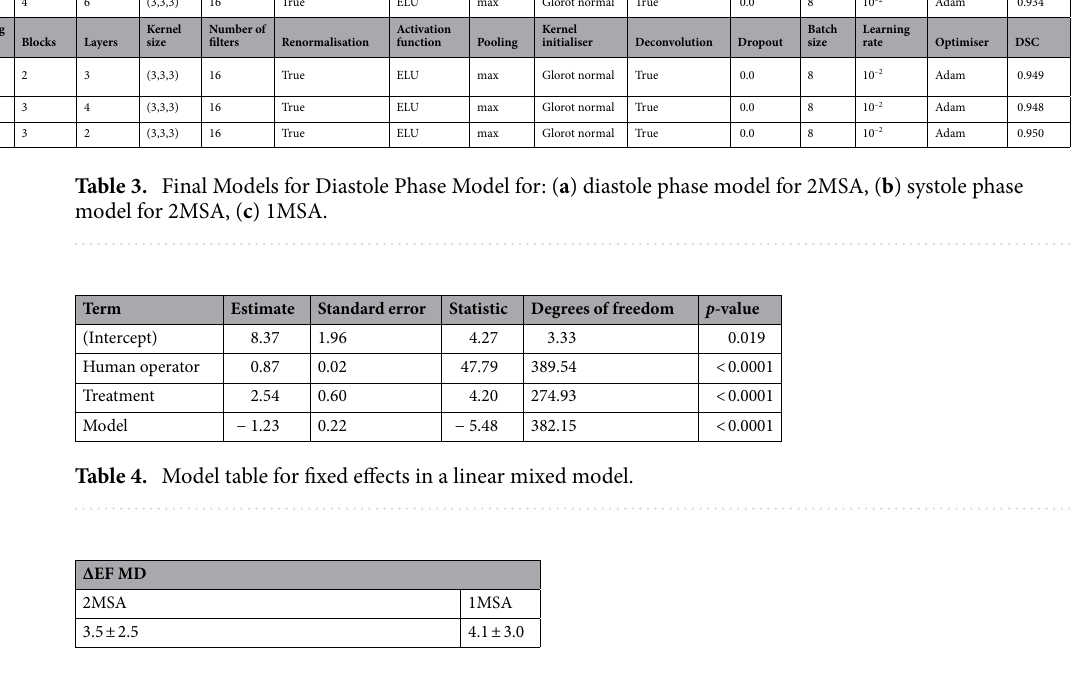
Table 5. Ejection fraction mean absolute difference for pooled Study 5 and Study 6 a . a Represented as MD ± standard